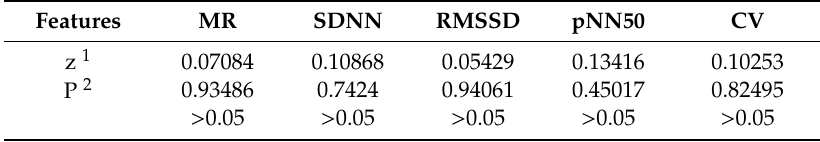
Figure 9. The slave and master units fixed on the sheep with elastic webbings. Table 5. Time-domain features by the normality test.